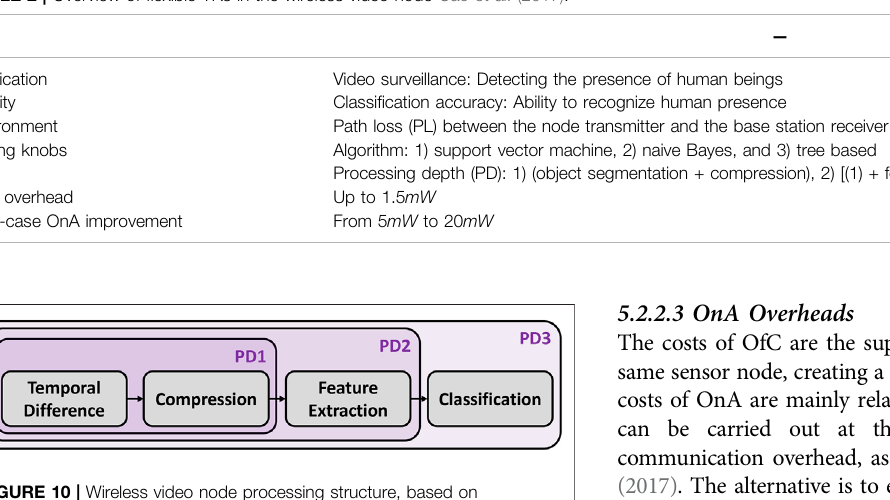
FIGURE 10 | Wireless video node processing structure, based on Figure 3 of the work of Cao et al. (2017).